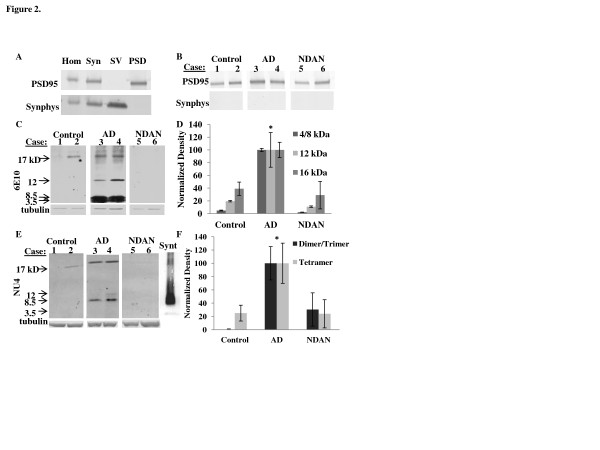
Synaptic fractionation demonstrates that low molecular weight Aβ oligomers associate with the PSD in AD but not NDAN hippocampal specimens. (A) PSD95, a postsynaptic marker, and synaptophysin (Synphys), a presynaptic marker, were probed in the total homogenate (Hom), synaptosomal (Syn), synaptic vesicles (SV), and postsynaptic density (PSD) fractions isolated from a frozen human hippocampal specimen from a control, non-demented aged individual. Enrichment of the different fractions is shown by the presence/absence of synaptic markers. The fractionation was successful for all case types (control, AD and NDAN) as shown by the purity of PSD fractions in (B). The isolated PSD fraction from hippocampal samples from different cases from each group (aged matched controls, AD, and NDAN) were immunoblotted together (representative blot shown; 40 μg protein each lane of a 10-20% tris-glycine gradient gel) and probed using 6e10 (C) showing LMW Aβ only associates with AD samples. (D) Densitometric analyses of each of the Aβ species (monomer/dimer = 4–8.5 kD band, trimer = 12 kD, and tetramer = 16 kD) demonstrates that all Aβ species are increased in AD. The results are expressed as the mean ± SEM using propagation of error and normalized with AD = 100%. The asterisk denotes the values significantly higher than control (monomer/dimer, p = 0.012, trimer, p = < 0.001, and tetramer, p = 0.014; ANOVA; a Bonferroni correction was required for the monomer/dimer and trimer density values). Hippocampus PSD fractions (80 μg) from age-matched controls, AD, and NDAN samples were immunoblotted and probed using NU4 (E). A lane is included at the end showing synthetic (Synt) Aβ oligomers probed by NU4 for comparison. The densitometric analysis (F) of the dimer/trimer band shows that AD cases are significantly higher than control and NDAN (both groups are essentially the same as background), while the tetrameric species was not found to be significantly different across the groups (p = 0.67). The asterisk denotes significance compared to control, p < 0.05, ANOVA. All Western blots shown are representative of 9–10 individual cases assayed in each group and experiments were repeated 3 – 4 times